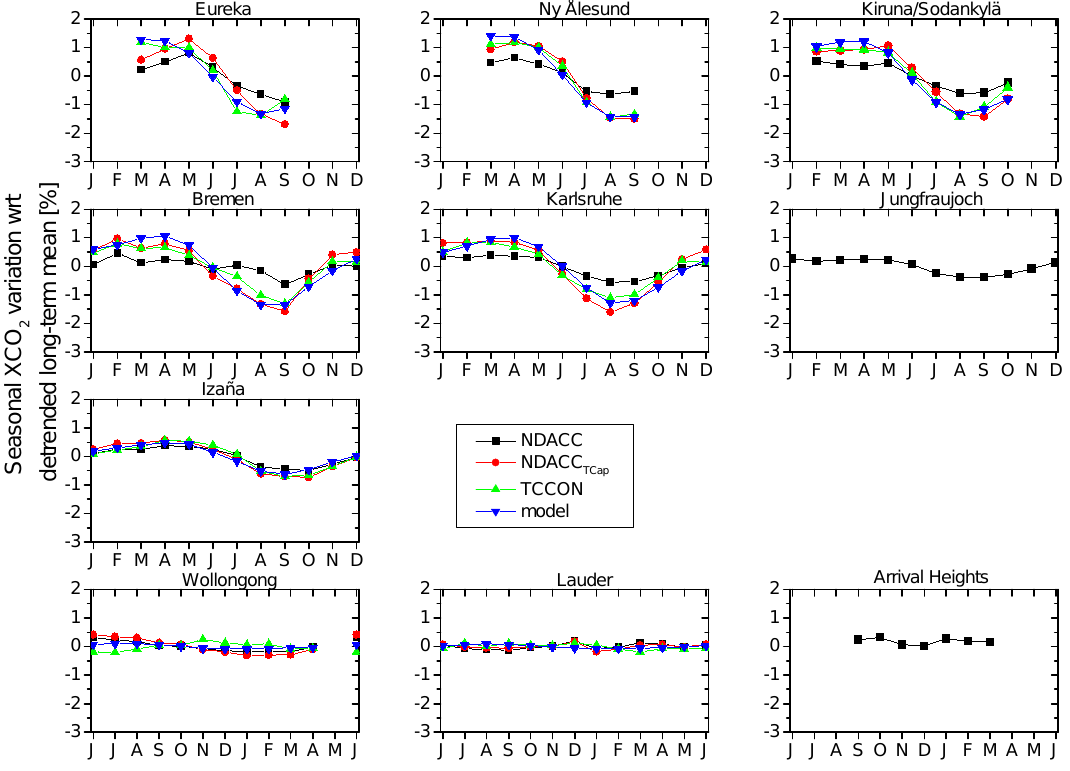
Figure A1. Seasonal cycles. Black: NDACC with fixed WACCM a priori, red: NDACC with same a priori as TCCON, green: TCCON and blue: